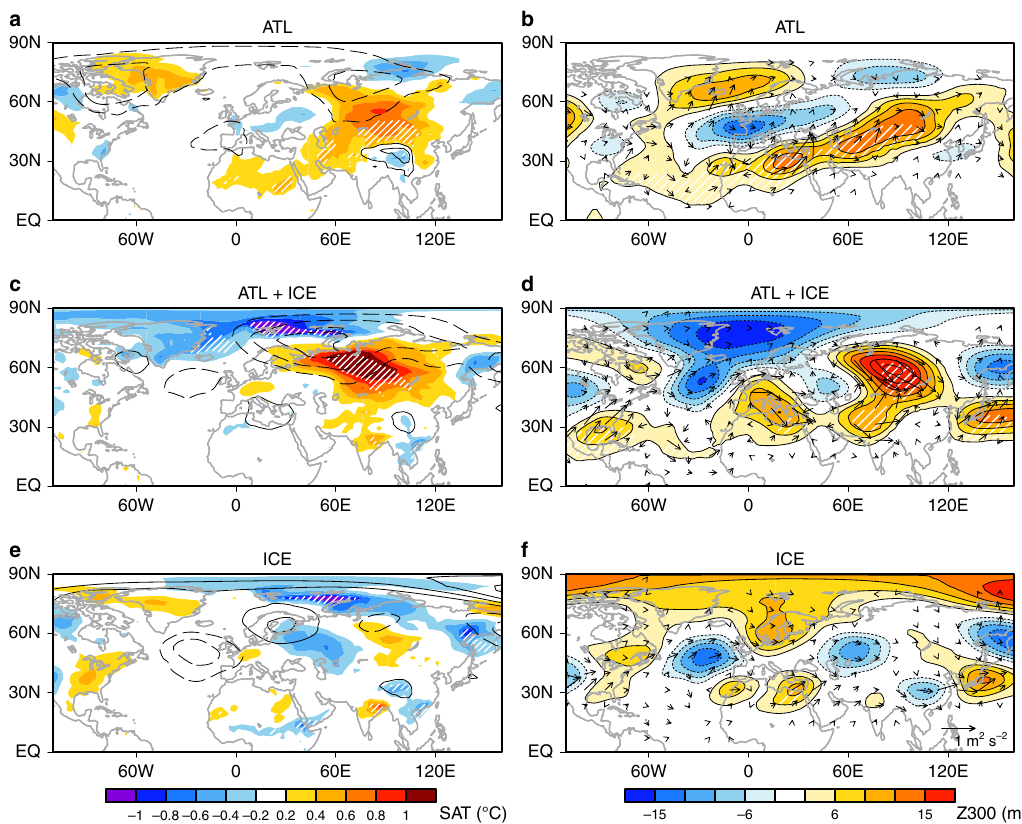
Fig. 4 Simulated atmospheric responses to tropical Atlantic warming and Arctic sea ice increase. Surface air temperature (SAT) (shading) and sea level pressure (SLP) (contours for ±0.5, ±1, … hPa; solid for positive and dashed for negative) in a ATL (tropical North Atlantic warming) — CTL (control experiment) difference, c ATL + ICE (tropical North Atlantic warming and Arctic sea ice increase) — CTL difference, and e ICE (Arctic sea ice increase) — CTL difference. b , d and f As in a , c and e , respectively, but for 300-hPa geopotential height (Z300) (shading) and wave activity fl uxes (vectors). Hatching indicates statistical signi fi cance at the p < 0.05 level for shaded